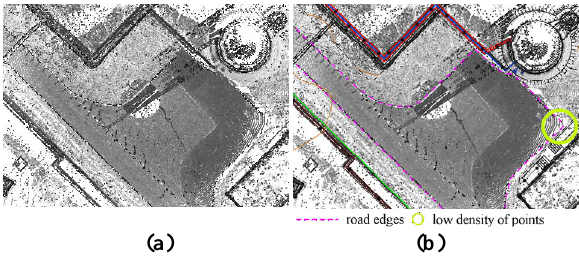
Figure 8 . The result of topographic plan production at the place of a road: ( а ) top view of the point cloud; (b) top view of the point cloud with extracted